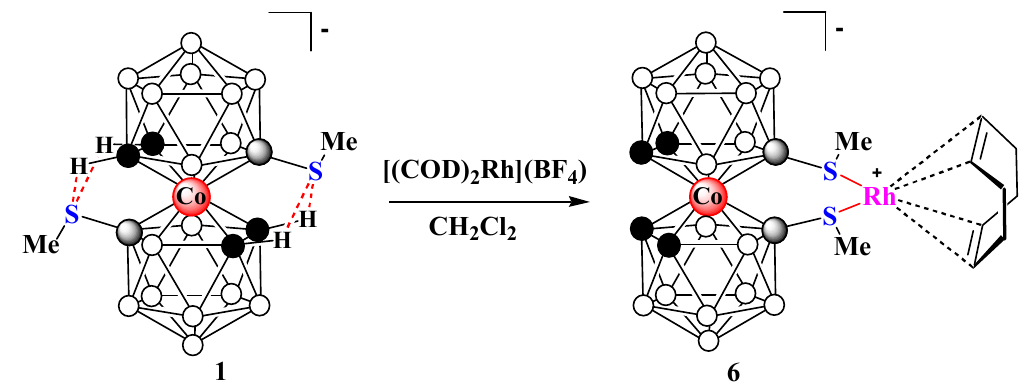
Figure 1. General view of complex 5 showing atomic numbering. Thermal ellipsoids are drawn at 50% probability level. Noncovalent C3-H3B…H9-B9 contact is shown by dashed line. The symmetrical rhodium complex {(COD)Rh[8,8′-(MeS) 2 -3,3′-Co(1,2-C 2 B 9 H 10 ) 2 -κ 2 -S,S’]} ( 6 )